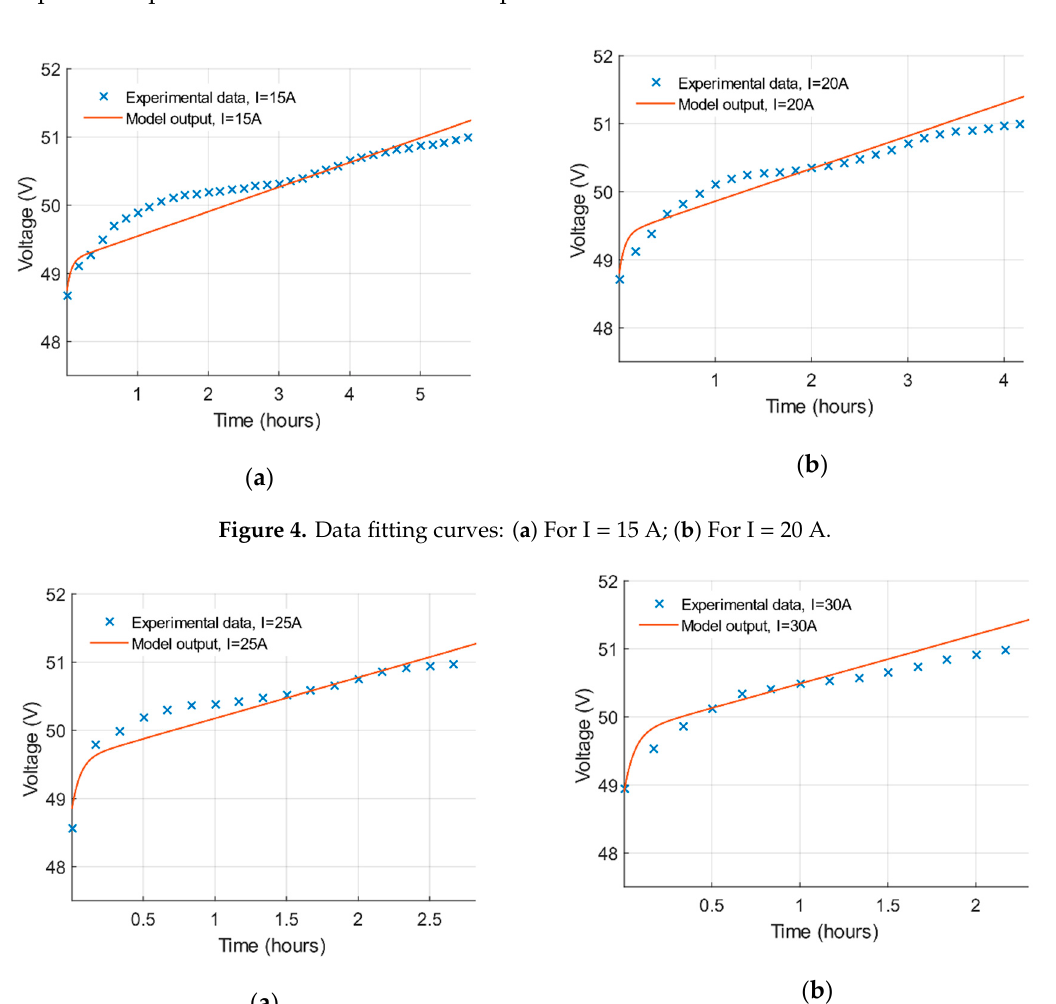
Figure 5. Data fitting curves: ( a ) For I = 25 A; ( b ) For I = 30 A.